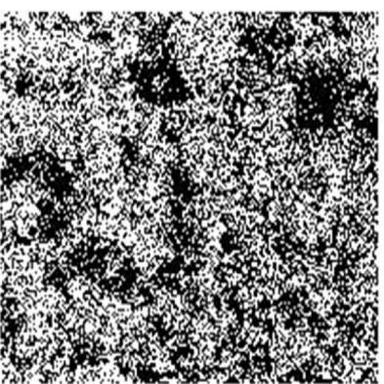
X-ray microanalysis of powders obtained by wet and dry milling: distribution maps of the Fe, Co, Nb, chemical elements on the starting sample (a) and the 5 h wet-milled sample (b) and 5 h dry-milled sample (c).